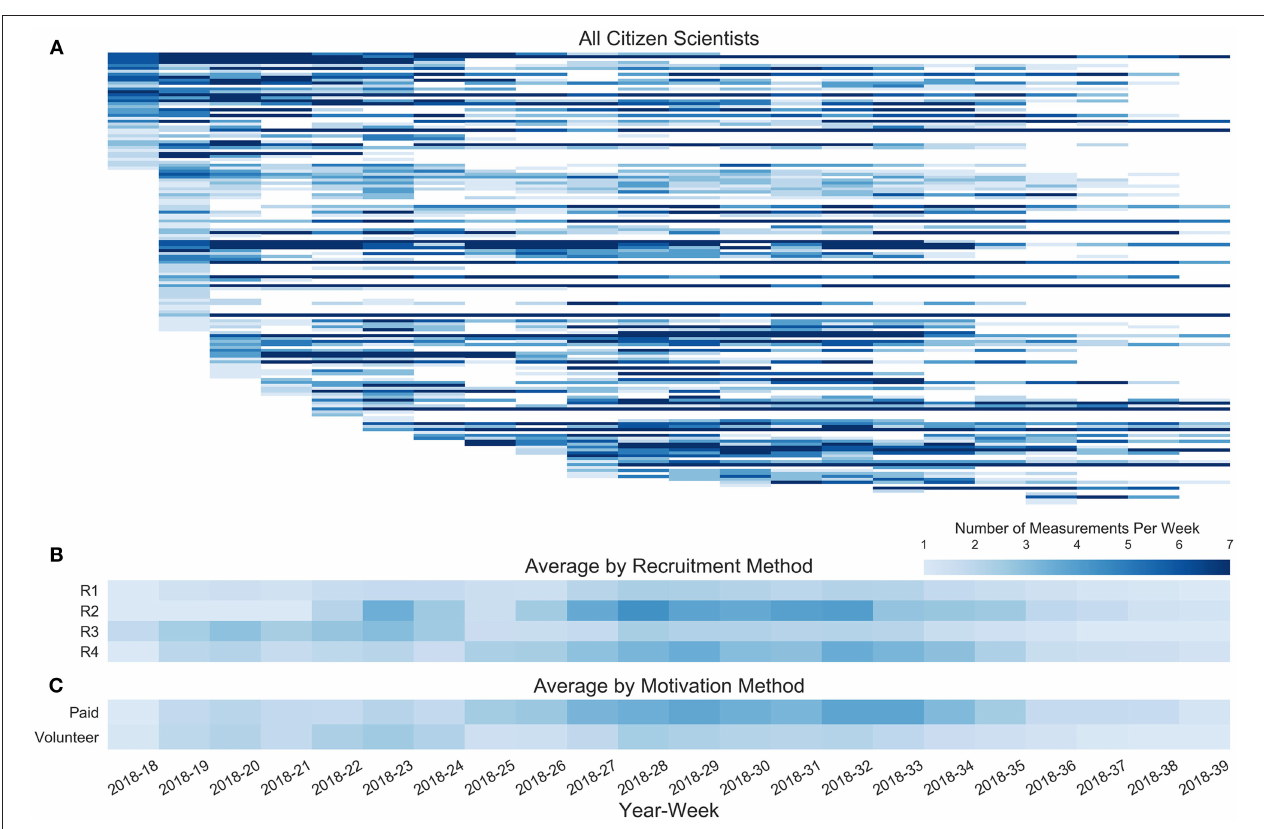
FIGURE 6 | Heatmap of the number of measurements per year-week for a 22-week period from the first week of May (i.e., 2018-18) through the end of September (i.e., 2018-39). Each column of pixels represents a single week. Each row of pixels represents (A) an individual citizen scientist ( n = 154), (B) averages from the four recruitment methods [i.e., R1: Leveraging personal relationships ( n = 53); R2: Social media ( n = 11); R3: Outreach programs ( n = 61); R4: Random site visits ( n = 29)], or (C) motivation method group [i.e., paid ( n = 37) or volunteer ( n = 117)]; see sections Recruiting and Motivating Citizen Scientists and Recruiting and Motivating Citizen Scientists Results for details). The color of each pixel represents the number of measurements performed each week. Light and dark blue represent one and seven measurements, respectively; white means zero measurements were performed that week. For panel (A) citizen scientists are sorted vertically in reverse chronological order by the date of their first measurement; the rate of recruitment is shown by the slope of the left edge of pixels in the heatmap—larger negative slopes (i.e., 2018-18 and 2018-19) represent higher recruitment rates. When computing grouped averages for panels (B,C) , zeroes were used for citizen scientists that did not perform measurements in the respective